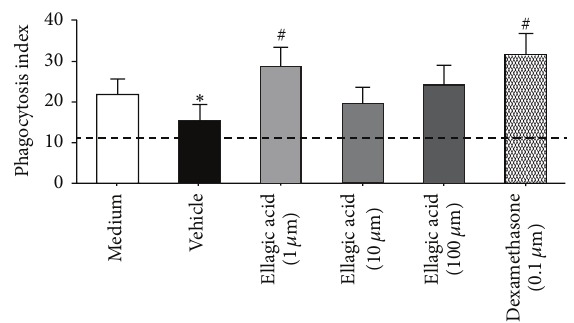
Figure 5: Ellagic acid increased macrophage phagocytosis of aller- gen. BALF cells on protocol day 21 (see Section 2), from OVA sensitized and challenged ( ex vivo ), were used to determine the phagocytosis index using rabbit anti-OVA IgG-coated beads (2mm) that are detectable by light microscopy. In nonpermeabilized cells, a fluorophore-tagged Ab (FITC-conjugated goat anti-rabbit Ab) was used to distinguish adherent (fluorescent) from internalized (nonfluorescent) beads (original magnification: 1000x). A phago- cytosis index was calculated after 15min in the presence of ellagic acid (1, 10, and/or 100 𝜇 M), dexamethasone (0.1 𝜇 M), vehicle, or medium (controls). Results represent the mean ± SEM of two or more independent experiments with three mice per group per experiment. ∗ 𝑃 < 0.05 compared with control (medium); # 𝑃 < 0.05 compared with vehicle